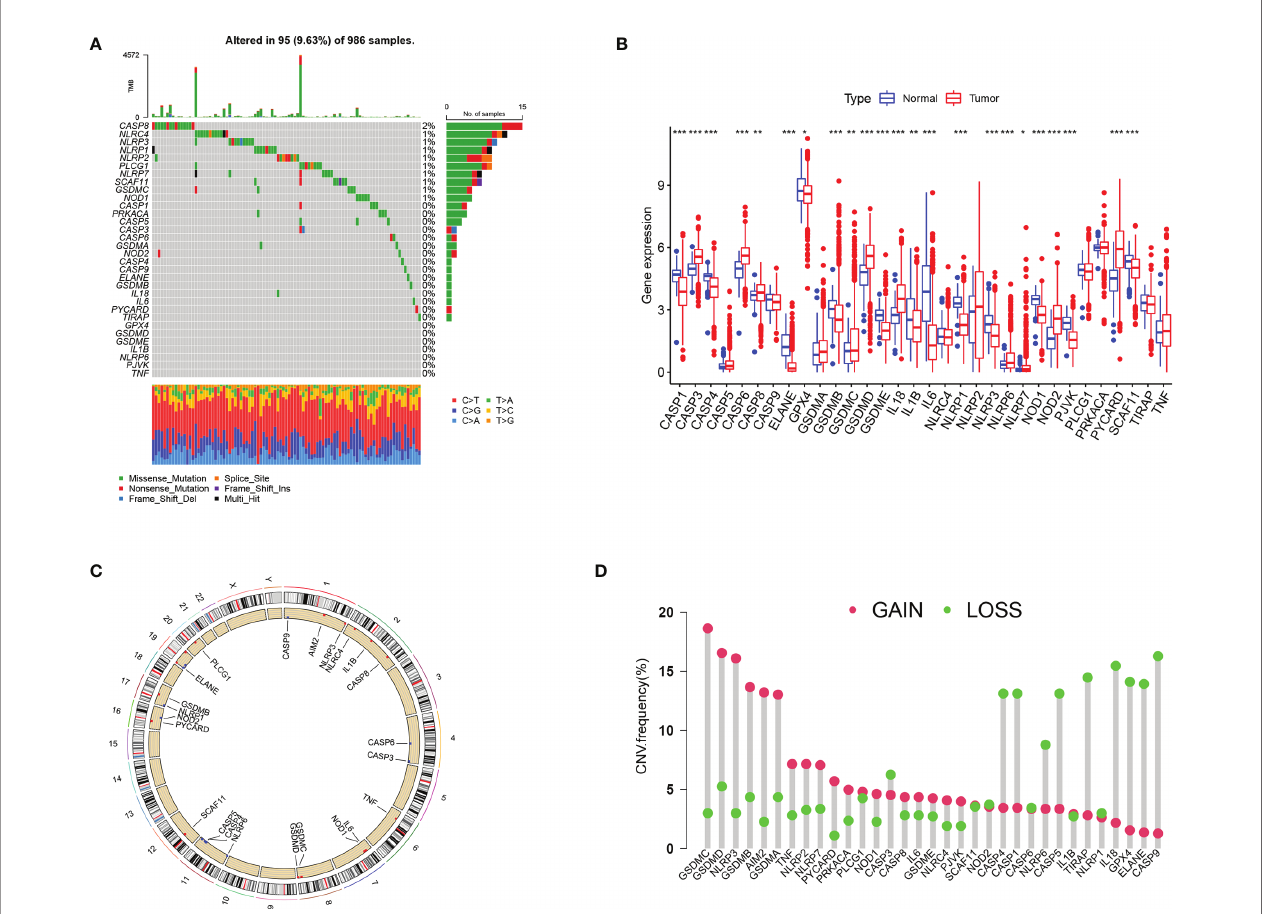
FIGURE 2 | The landscape of genetic variation and expression of pyroptosis-related genes in BRCA. (A) Genetic alteration on a query of pyroptosis-related genes. (B) Gene expression levels of pyroptosis-related genes in BRCA compared to normal tissue. (C) The location of the CNV alteration of the pyroptosis-related genes changes on 23 chromosomes. (D) The frequency of CNV variation in pyroptosis-related genes. Red dots represent CNV ampli fi cation, while green dots represent CNV deletion. * P < 0.05, ** P < 0.01, *** P <